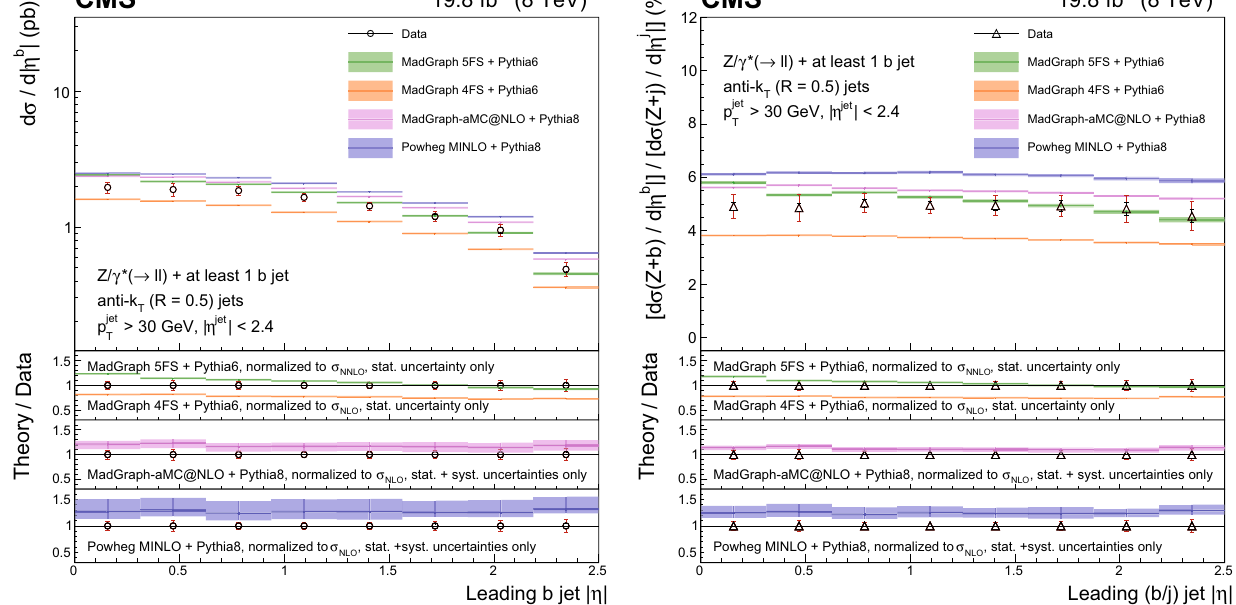
in the text. For each data point the statistical and the total (sum in quadrature of statistical and systematic) uncertainties are represented by the double error bar . The width of the shaded bands represents the uncertainty in the theoretical predictions, and, for NLO calculations, theoretical systematic uncertainties are added in the ratio plots with the inner darker area representing the statistical component